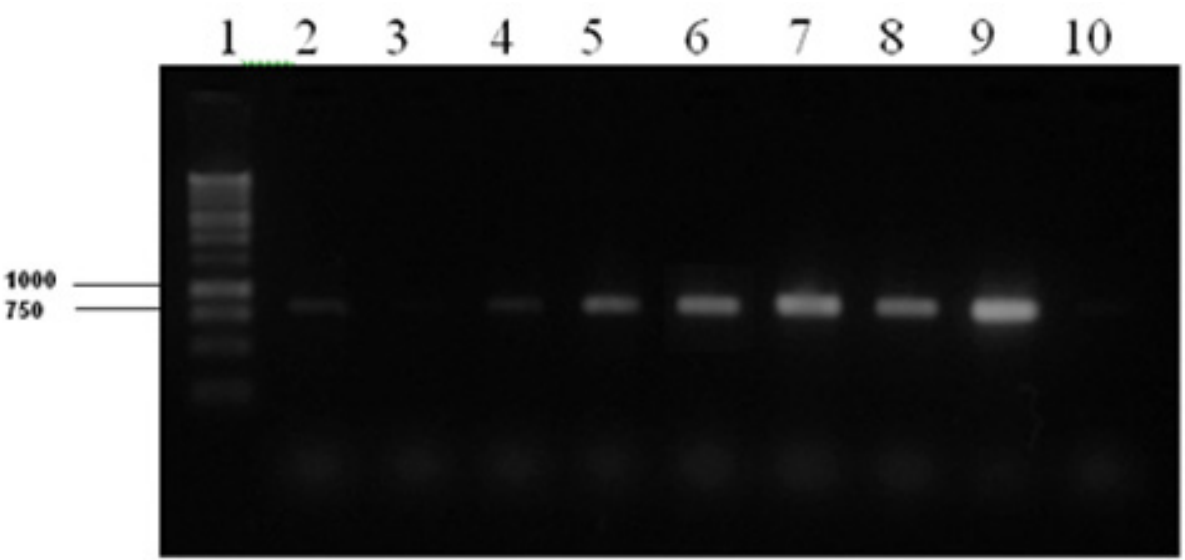
Figure 2. Electrophoresis on 2% agarose of RT-PCR over eight days of infection with DENV-2. Lane 1: molecular weight marker (1 kb, Promega, USA); lane 2: DENV-2 first day; lane 3: DENV-2 second day; lane 4: DENV-2 third day; lane 5: DENV-2 fourth day; lane 6: DENV-2 fifth day; lane 7: DENV-2 sixth day; lane 8: